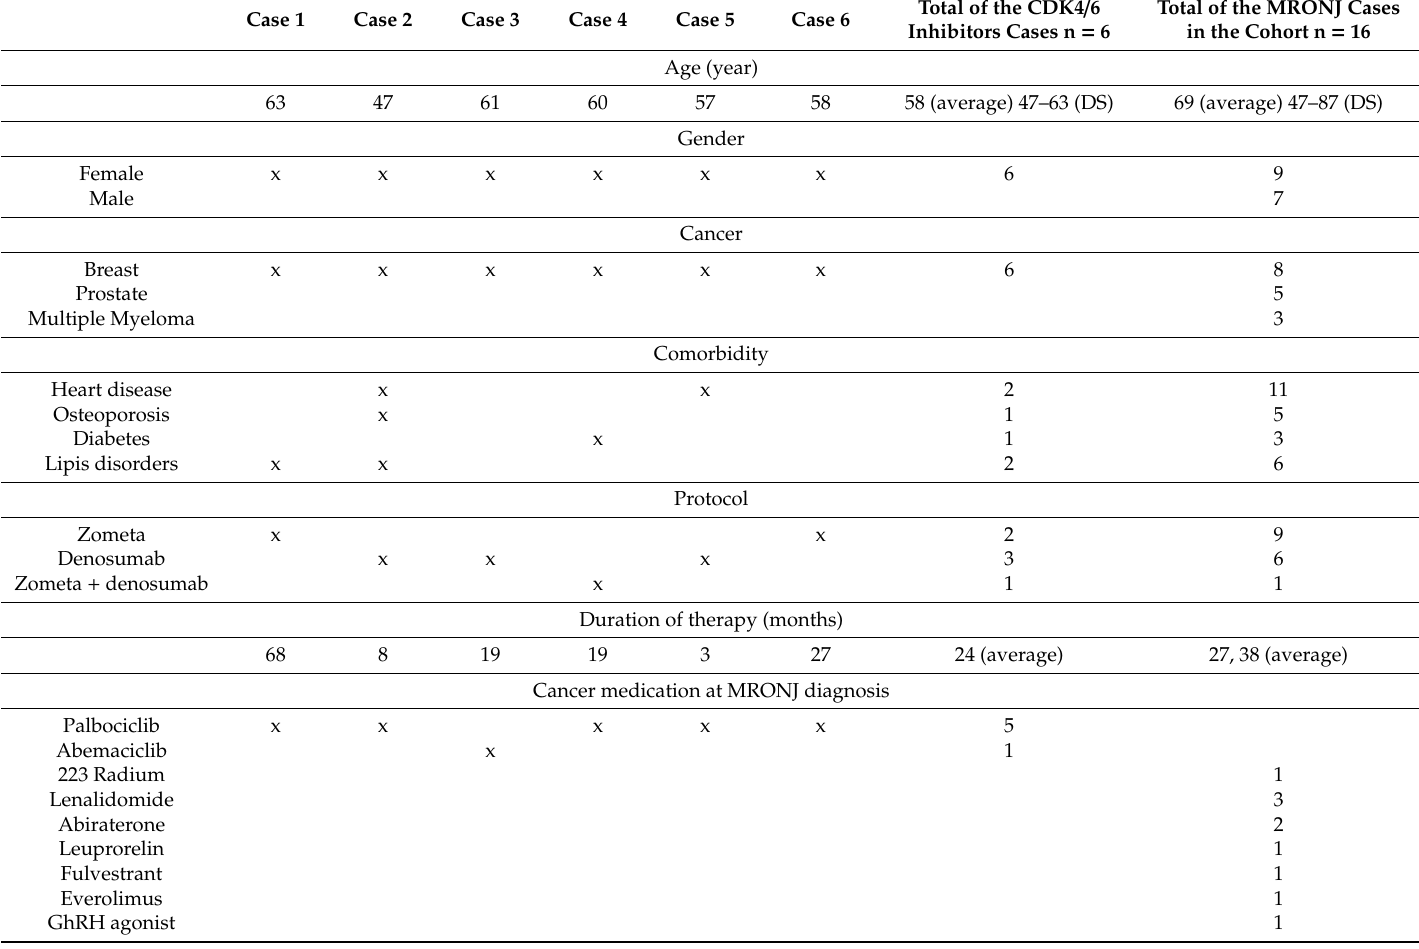
Table 1. Characteristics of patients with cyclin-dependent kinase (CDK) 4 / 6 inhibitor-associated medication-related osteonecrosis of the jaw (MRONJ) and cancer in the